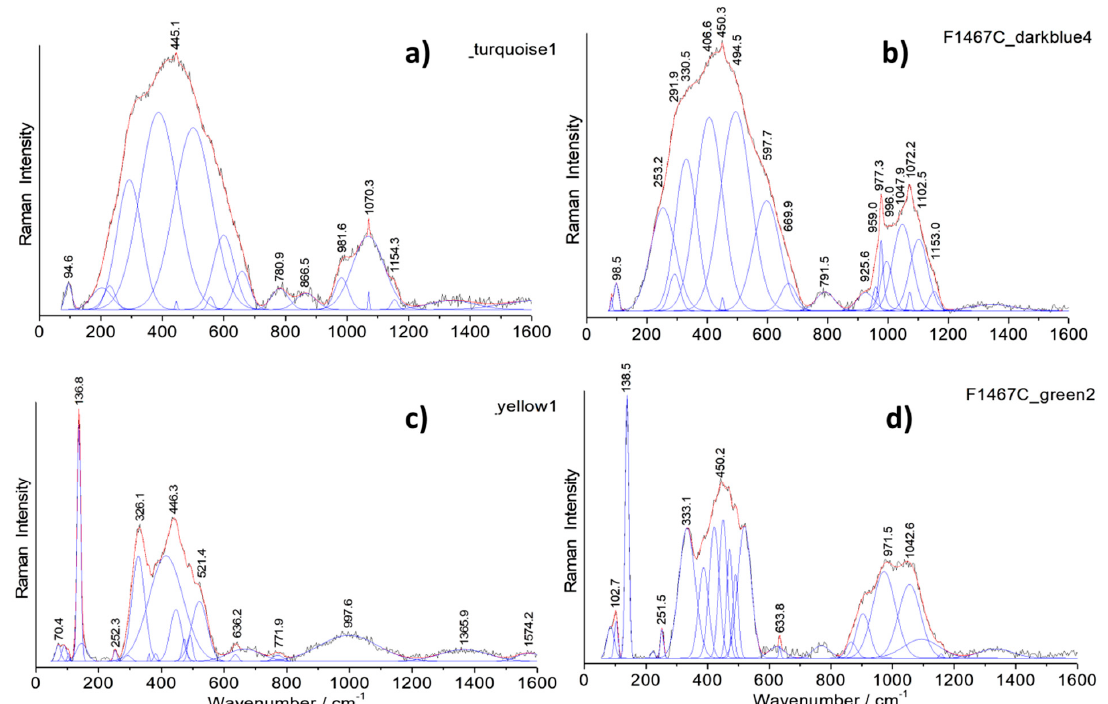
Figure 9. Representative Raman spectra recorded on the cloisonn é enamels of the ewer (baseline subtracted): turquoise ( a ), dark blue ( b ), yellow ( c ), and green ( d ). Gaussian and Lorentzian components used to separate the contribution of the crystalline pigment from that of the glassy matrix are shown.